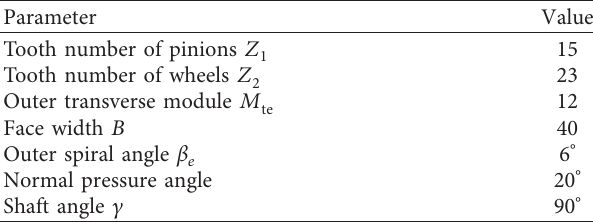
Table 1: Basic geometric parameters of gear